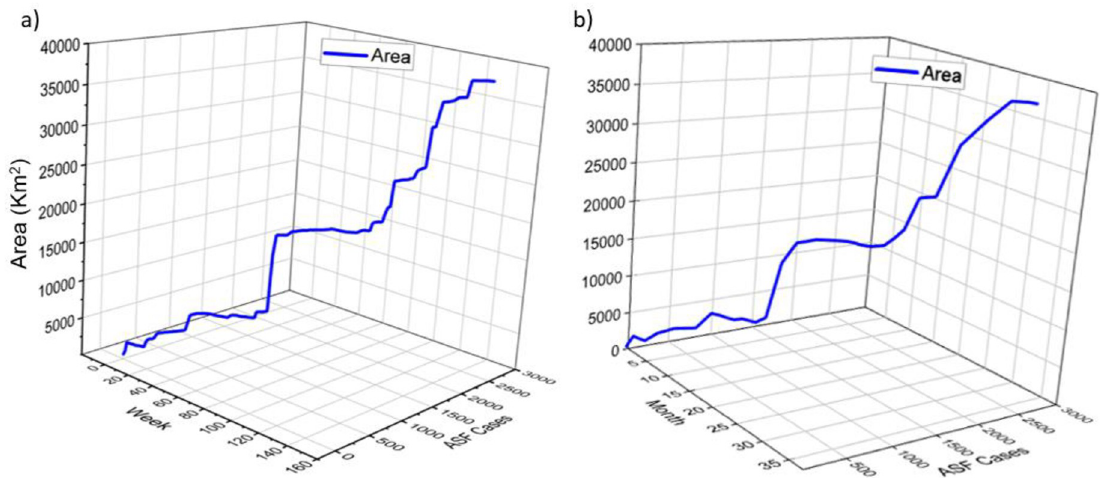
Fig 3. The growth of ASFV cases and polygon size (km 2 ) on a (a) weekly and (b) monthly